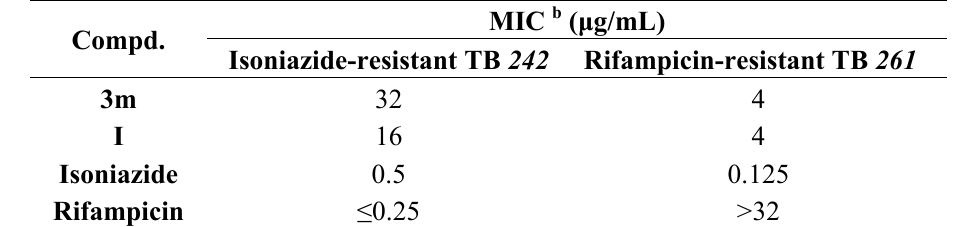
Table 2. The MIC values of compound 3m against two resistant M. tuberculosis strains isolated from clinical cases a .